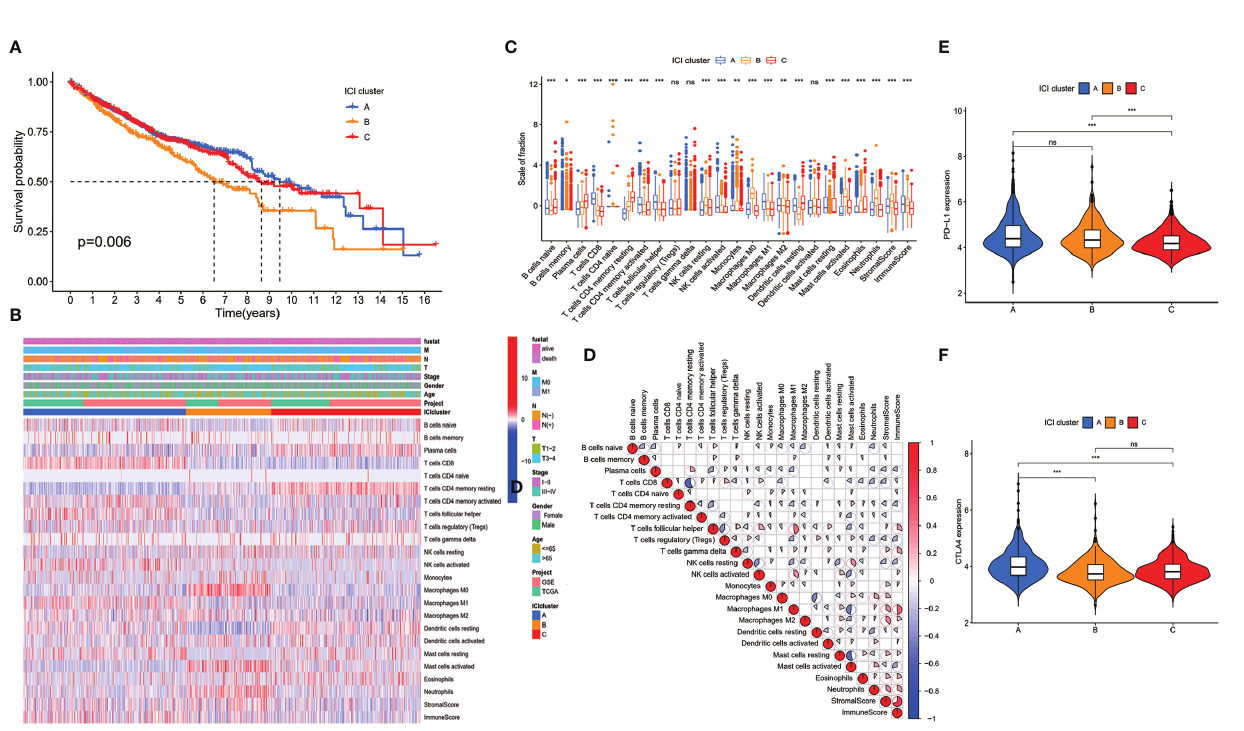
FIGURE 1 | Immune cell in fi ltration (ICI) in tumor environment of colon cancer patients. (A) Colon cancer patients were classi fi ed into three clusters according to ICI in tumor microenvironment. Rows represent immune cells in fi ltrated in tumor microenvironment, and columns represent samples. (B) Overall survival of colon cancer patients in the three ICI clusters (log-rank test, p = 0.006). (C) The proportion of immune cells in three ICI clusters. The immune score and stromal score of three ICI clusters were also plotted (mean ± SD, Kruskal – Wallis test. * p < 0.05; ** p < 0.01; *** p < 0.001). (D) Cellular interaction of the tumor-in fi ltrating immune cell types. (E) PD-L1 expression and (F) CTLA4 expression in the three ICI clusters (Kruskal – Wallis test, *** p < 0.001; ns, non signi fi